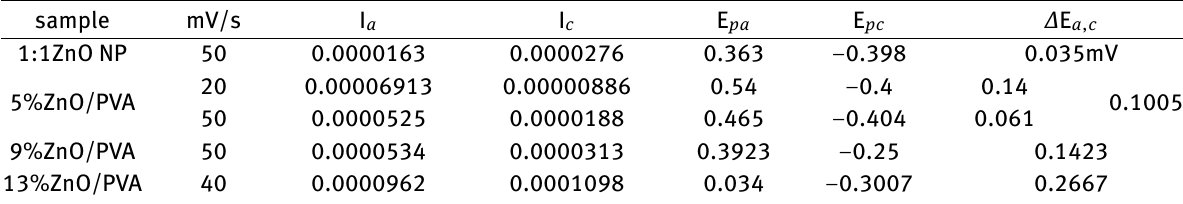
Table 4: Electrochemical parameters of CV analysis of ZnO NPs and ZnO/PVA NCs.